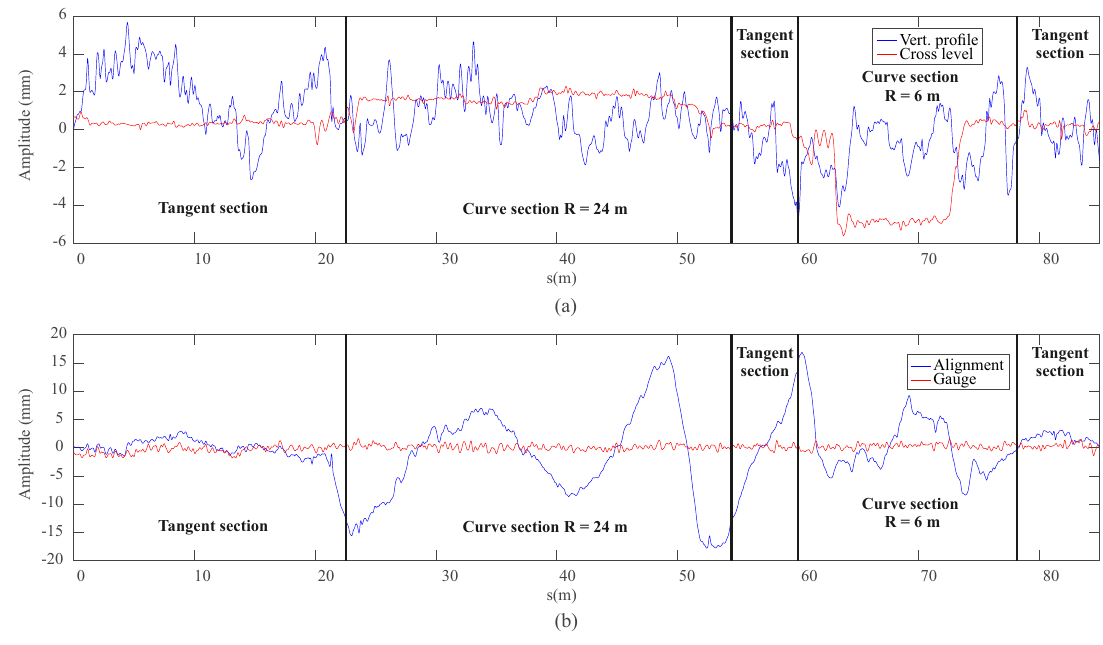
Figure 5. Author measuring the TCL with the robotic total station ( a ). Track gauge and cant angle measuring device ( b ).